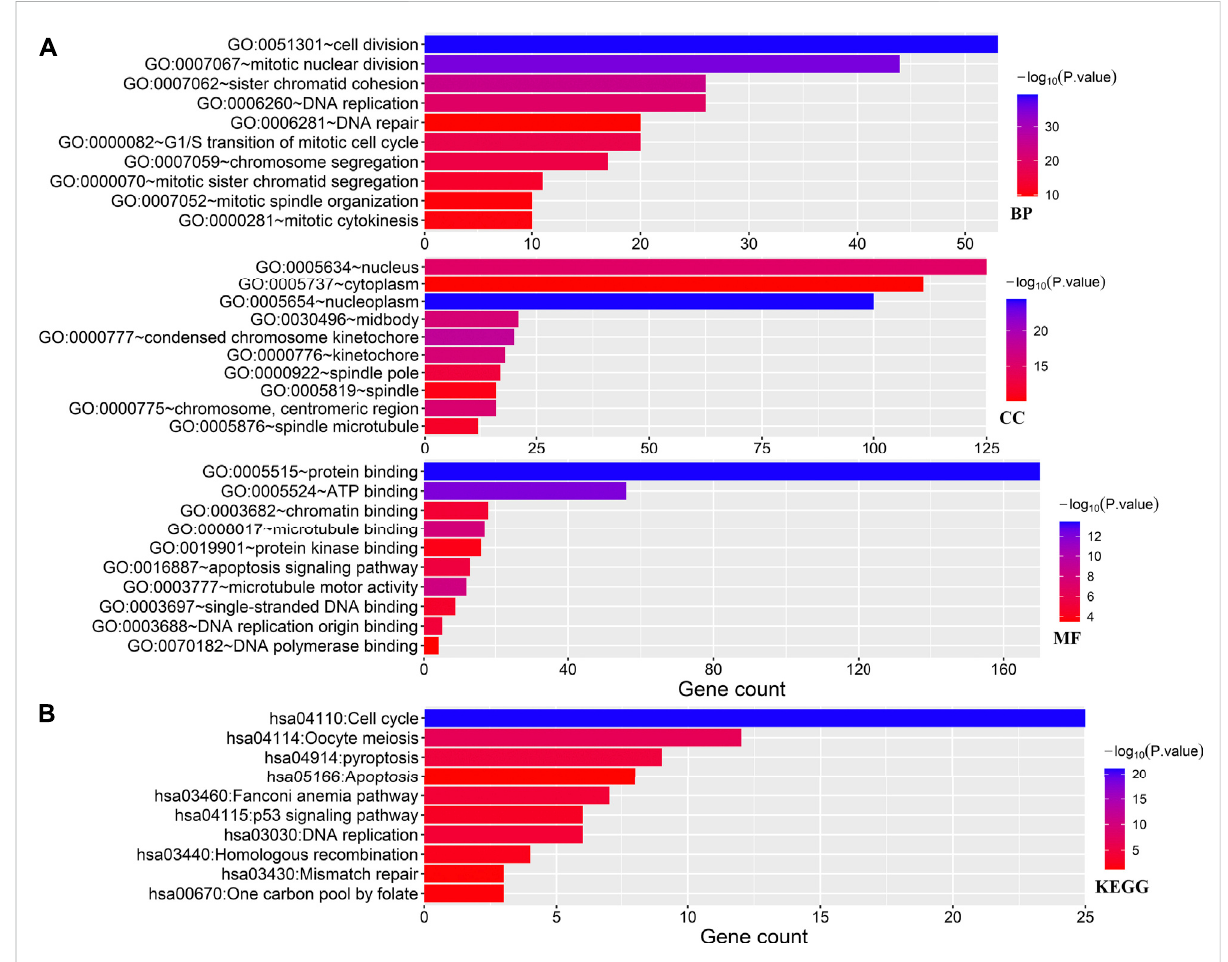
FIGURE 2 GO and KEGG analyses. (A) Enriched items in the GO analysis. (B) Enriched items in the KEGG analysis. GO, gene ontology; KEGG, Kyoto Encyclopedia of Genes and Genomes; BP, biological process; CC, cellular component; MF molecular